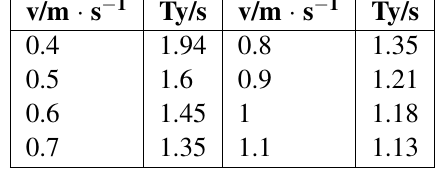
Table 3 Exercise cycles of the same subject at different walking speeds.